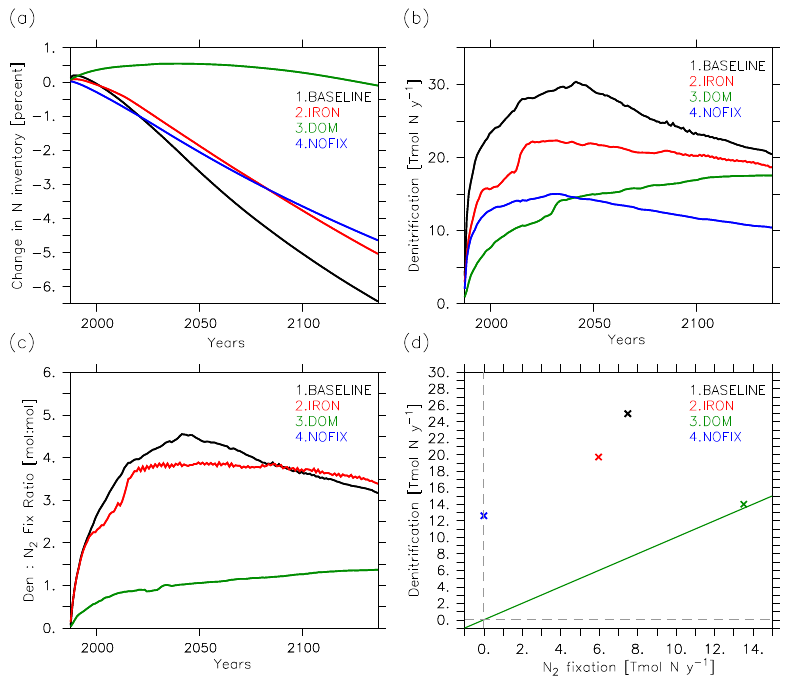
Fig. 5. Temporal evolution of (a) simulated oceanic N inventory (changes in %), (b) global denitrification rates (TmolNyr − 1 ), (c) ratio of global denitrification to global N 2 fixation (mol:mol). Panel (d) shows scatter plots of the 150-yr mean global denitrification versus 150-yr mean global N 2 fixation for the BASELINE, NOFIX, IRON and DOM simulations. The green line has slope 1 and indicates a balanced oceanic nitrogen inventory.